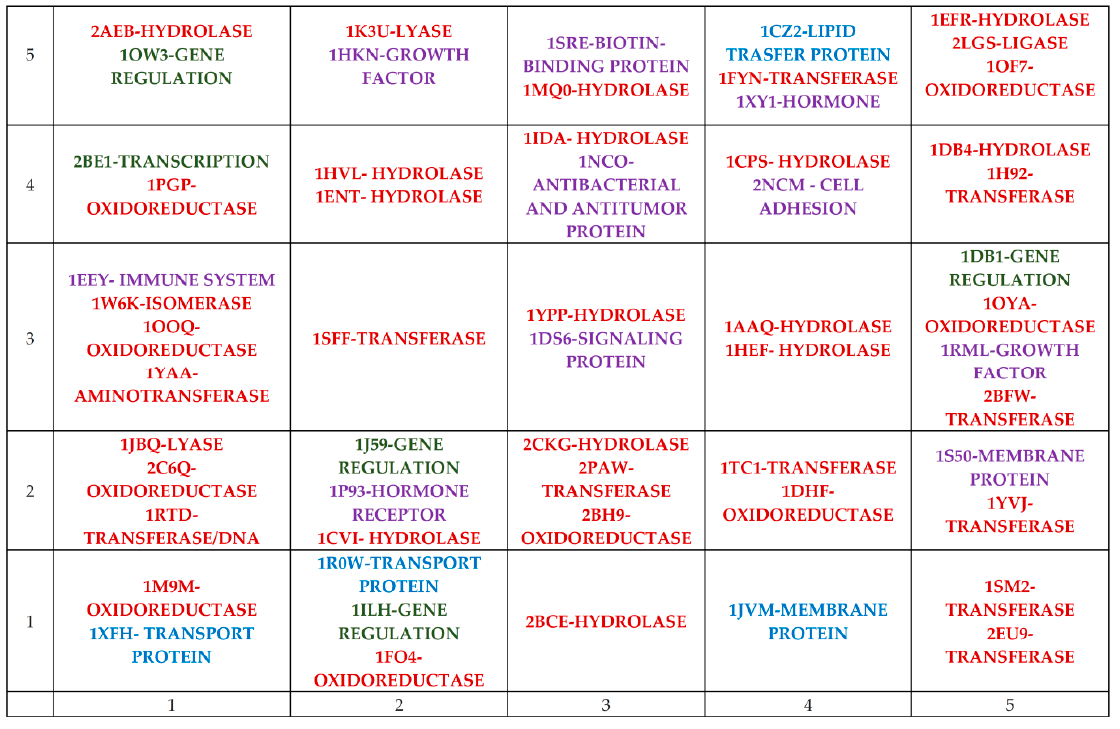
Figure 1. The Kohonen map (5 × 5) with distribution of 57 proteins.